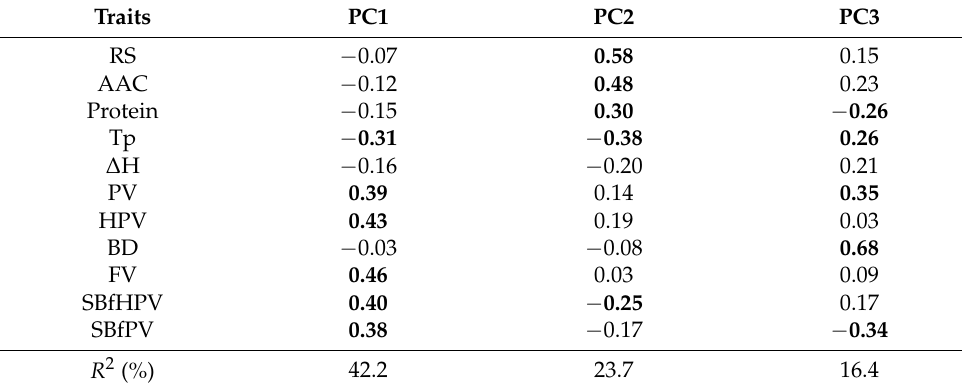
Table 4. PCA analysis of traits of grain quality and RVA parameters ‡ . Table 4. PCA † analysis of traits of grain quality and RVA parameters ‡ . Traits Traits